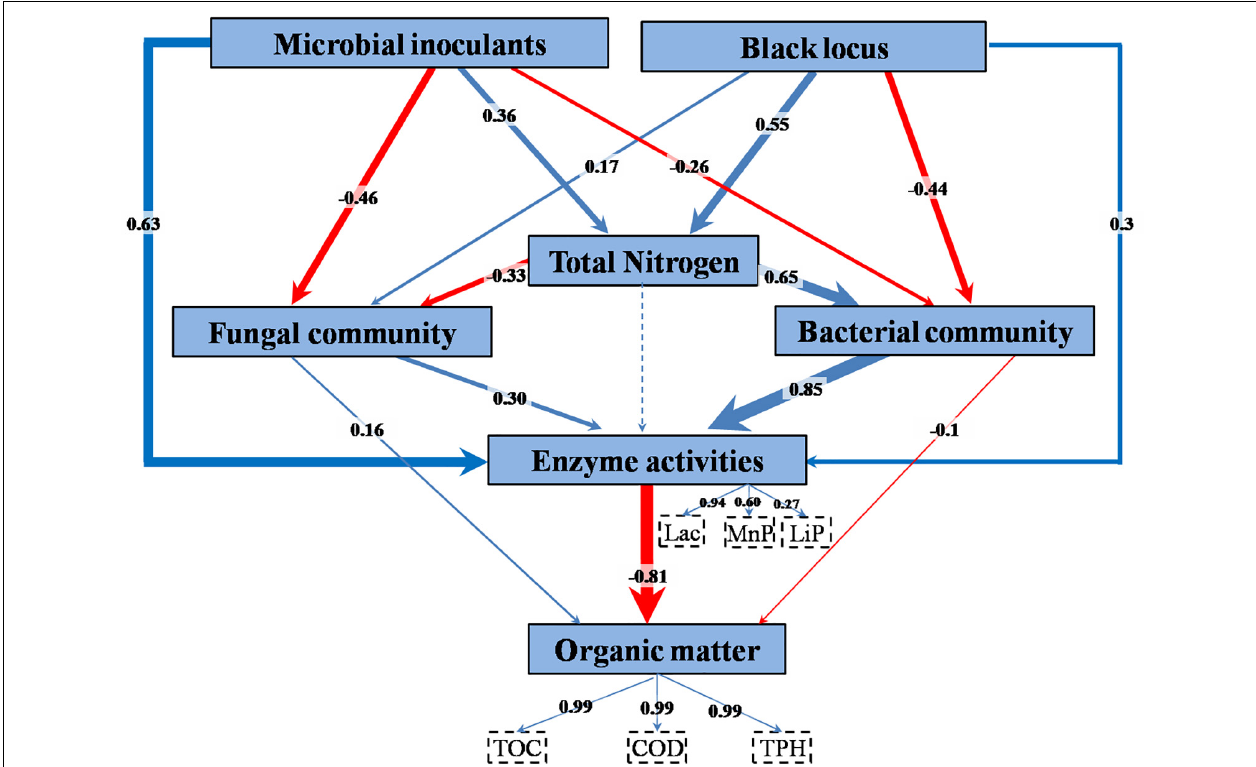
FIGURE 7 | Partial least squares path model of remediating waste drill cuttings. A box represents an observed variable or a latent variable (i.e., a construct). The loadings for enzyme activities and organic removal rates that create the latent variables are shown in the dashed rectangles. Path coefficients are computed after 1,000 bootstraps and embodied in the width of the arrow, with blue and red indicating positive and negative effects, respectively. Dashed arrow shows a coefficient that did not differ significantly from 0 ( P > 0.05). TN, total nitrogen content; Lac, laccase; MnP, manganese peroxidase; LiP, lignin peroxidase; TOC, total organic carbon content; COD, chemical oxygen demand; TPH, total petroleum hydrocarbon